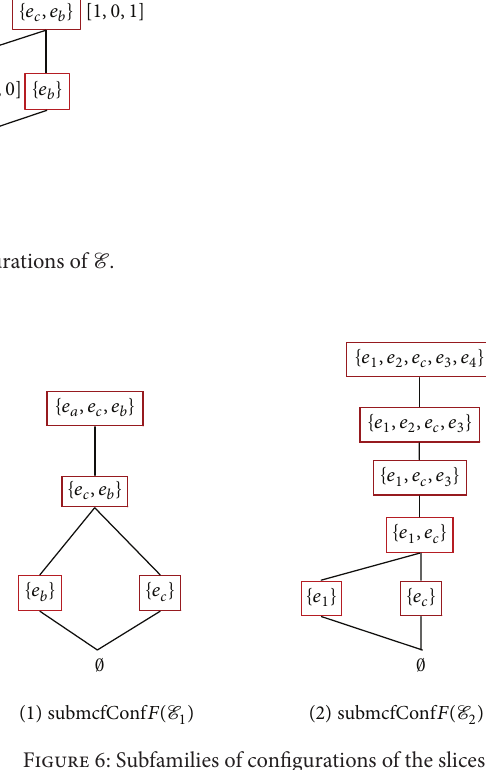
Figure 6: Subfamilies of configurations of the slices.